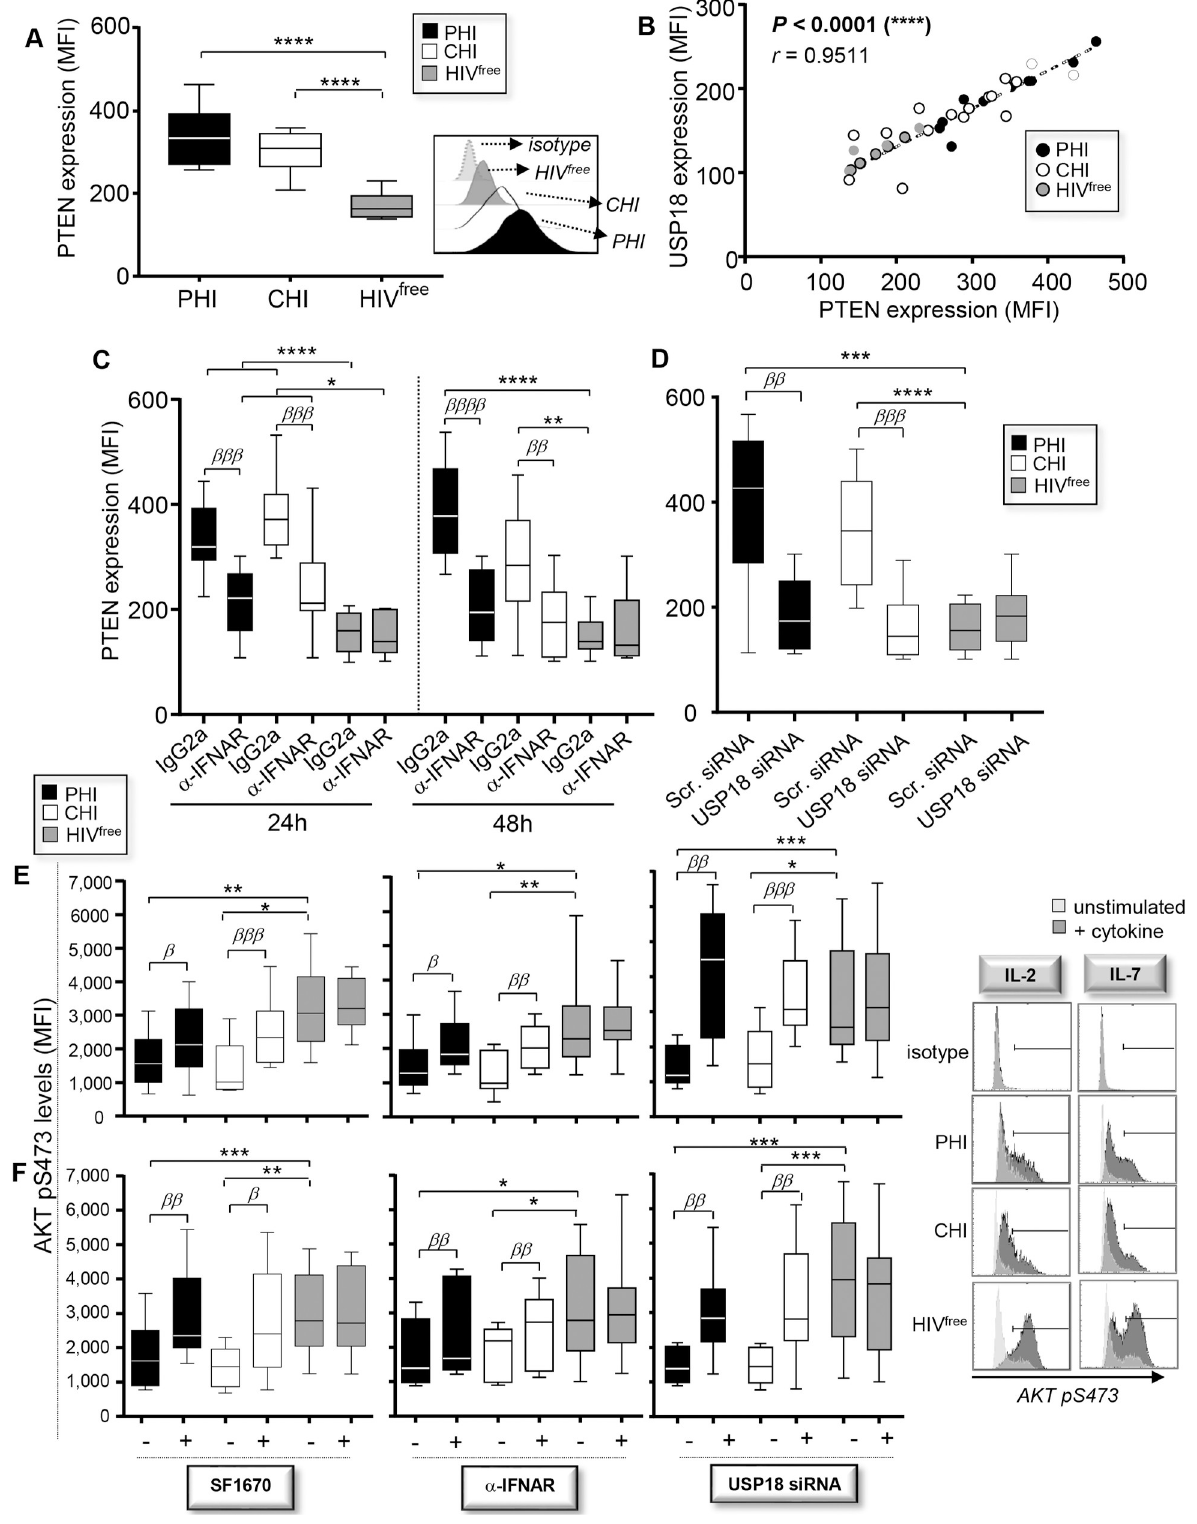
Fig 2. High USP18 expression in Mem from PHI and CHI impairs AKT activation. ( A ) Ex vivo PTEN expression levels in Mem from PHI, CHI and HIV free subjects (MFI) (n = 10). Representative histograms including isotype control are also shown above. ( B ) Correlations between USP18